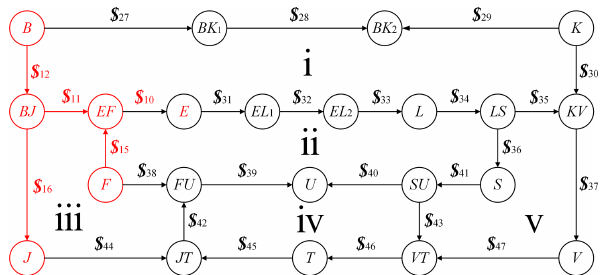
Figure 10. Structural decomposition.